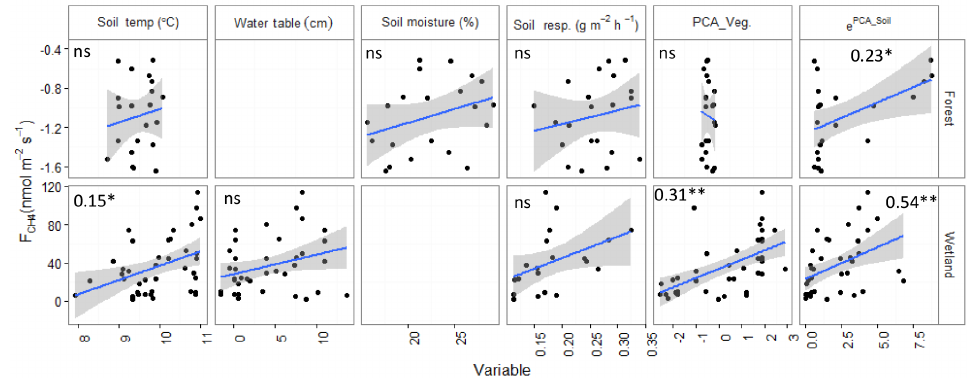
Figure 4. Relationships between geometric mean CH 4 flux (nmolm − 2 s − 1 ) against measured environmental variables across full sampling period. Text refers to the results from statistical correlations, where “ns” refers to a non-significant results ∗ and ∗∗ represent P <0.05 and P <0.01,